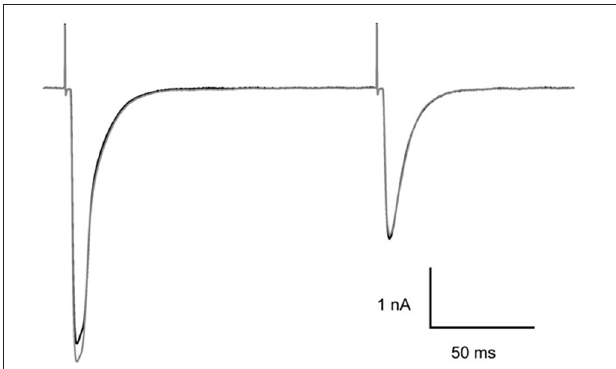
FIGURE 3 | Effect of MNI-caged γ - D GG on CF-PC synaptic transmission. Paired pulse stimulation at 150 ms interval before (black trace) and 5 min after addition of 4.6 mM MNI-caged γ - D GG to the bath (gray trace). Pipette potential − 40 mV, 21 ◦ C.